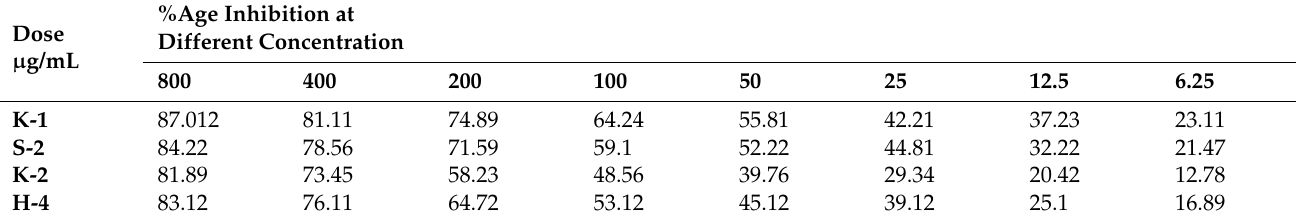
Table 5. Results of alpha amylase inhibition assay.